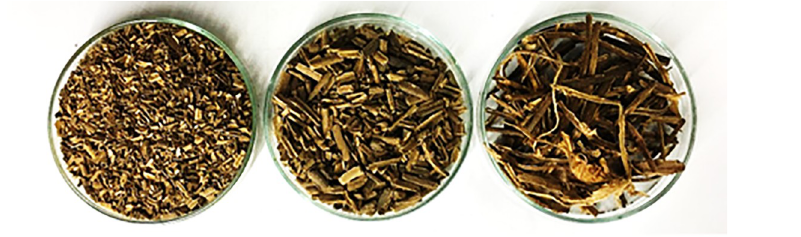
Fig 1. Tobacco residues with particle sizes 0.5 cm, 1 cm, and 3–5